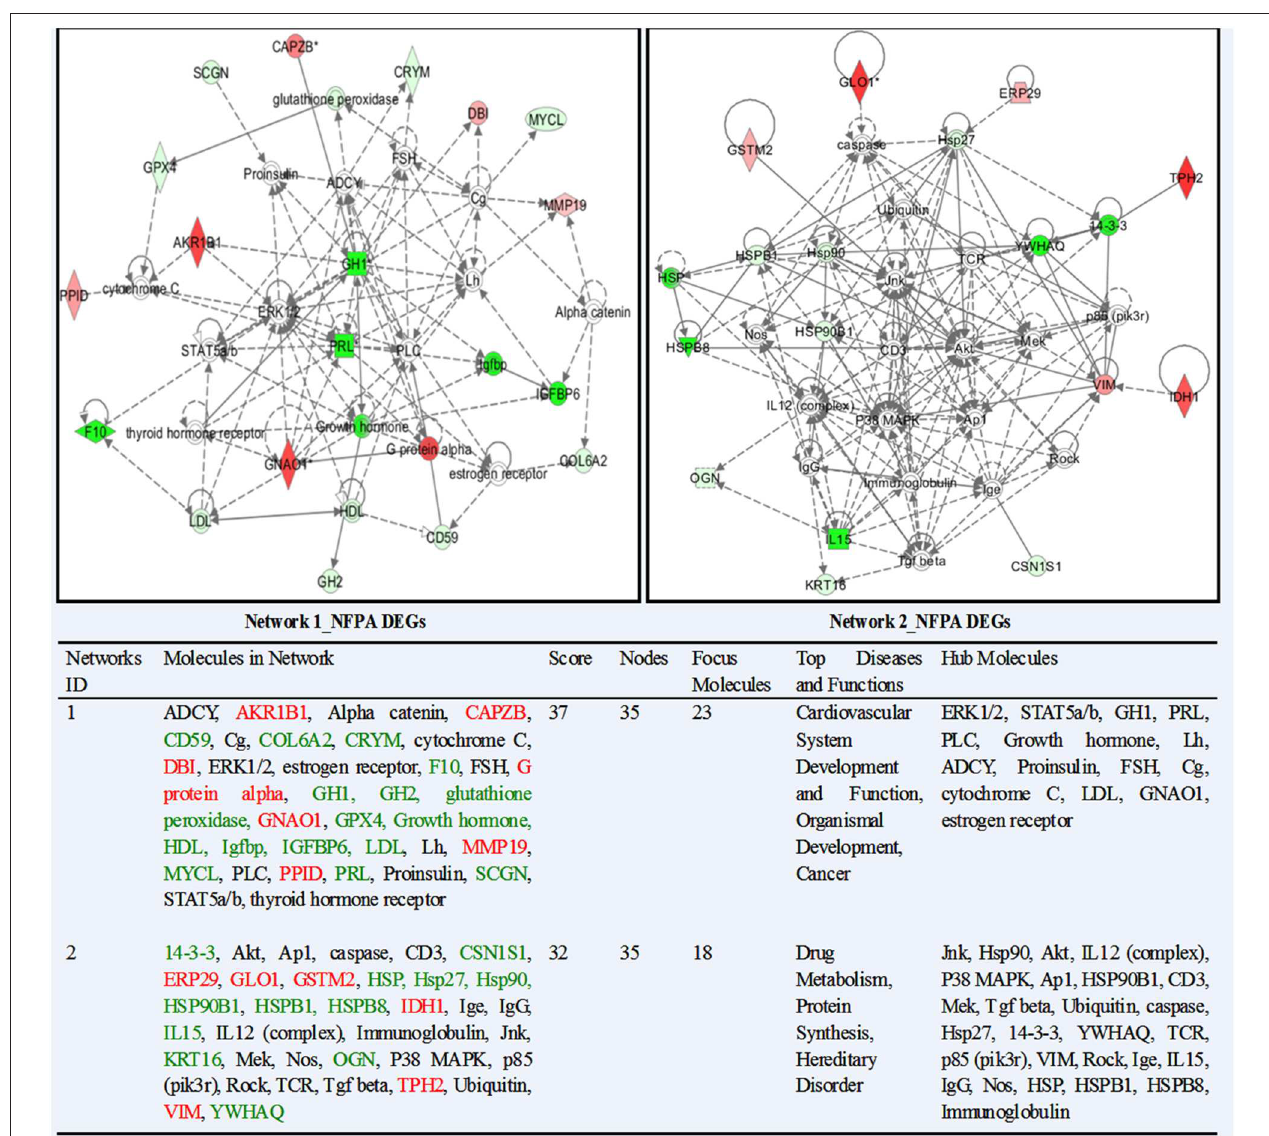
FIGURE 2 | The representative molecular networks derived from NFPA DEG